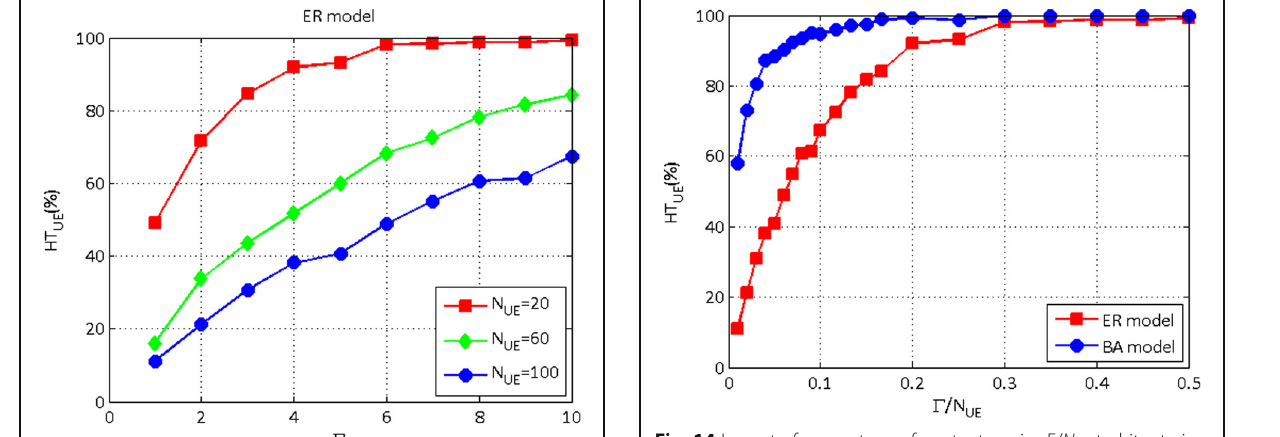
(cid:3) T SBS as well as different network model. The per- T UE formance of CCSOA on hit rate is compared with CEE and ProbCache.